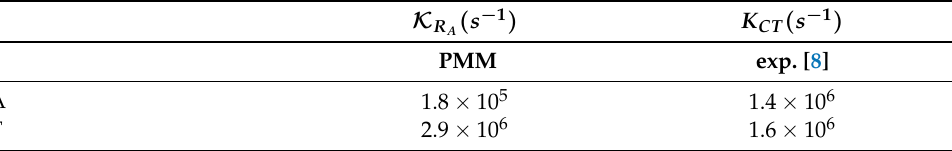
and the experimentally measured rate A –A–C 3 and G . + –T–C 3 sequence containing 2 2